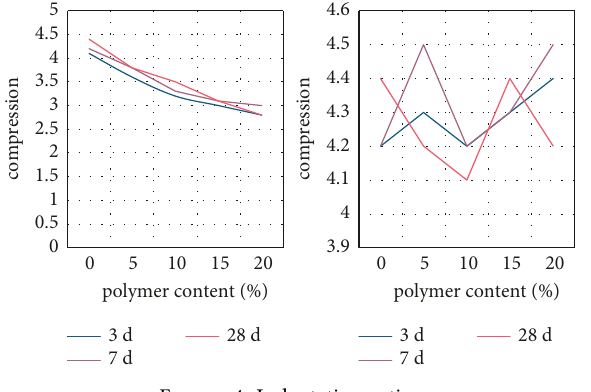
Figure 4: Indentation